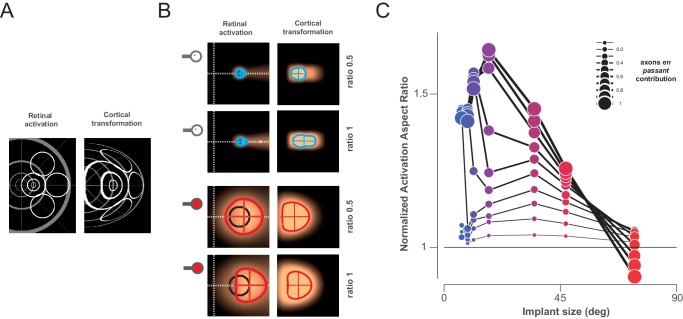
Model of retino-cortical transformation.To check whether retino-cortical transformation can introduce further bias to our predictions (Figure 4—figure supplement 1), we implemented a retino-cortical transformation based on the magnification measured in our data (A). This model simply generates a transformation using the formula RCM = 1 /(aR+b), where RCM is the retino-cortical magnification factor (mm/deg), R the retinal eccentricity (deg), a and b constants (along the horizontal meridian : a = 0.7; b = 30 & a = 0.4, b = 40 for the vertical dimension). In the Figure A, the resulting transformation is shown for a retinal pattern with circles of different diameter and eccentricity. (B) We show for 2 cone angles (blue and red) and ratio of axon-en-passant (same as Figure 4—figure supplement 1), what such transformation does. (C) From these maps, we calculated the cortical activation aspect ratio, normalized to the shape of activation without axon-en-passant (ratio = 0 not shown), plotted with the same convention as in Figure 4C.